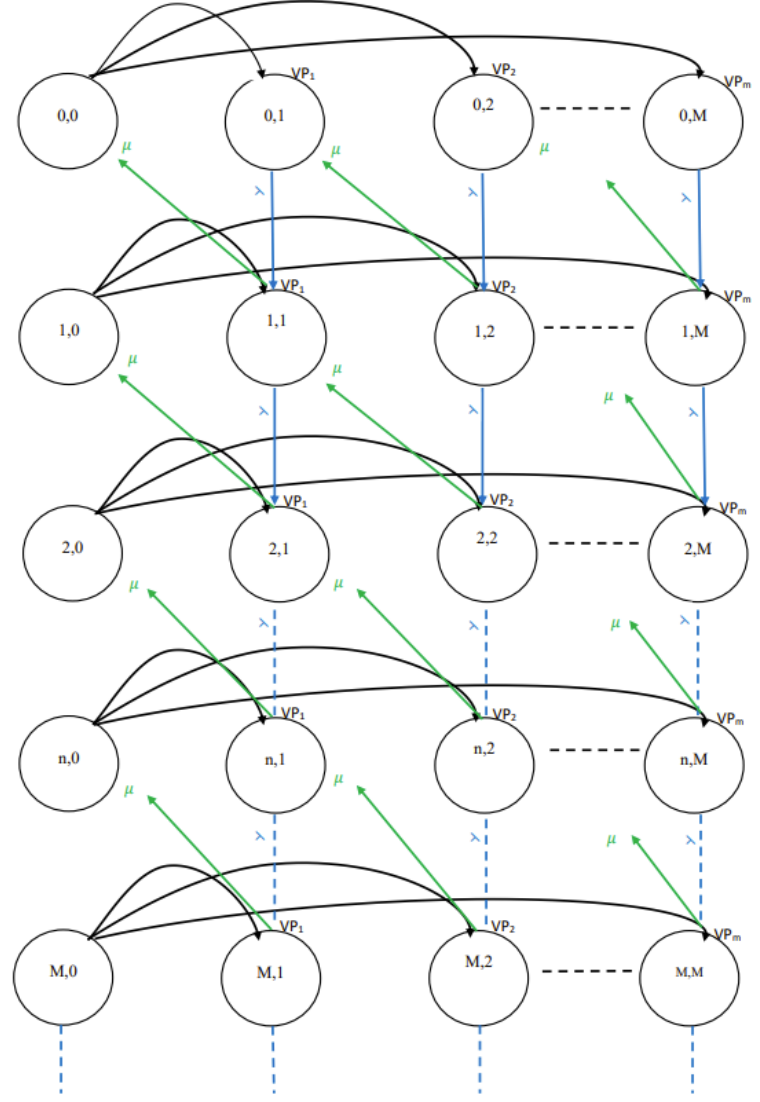
Figure 1. Integrated queuing-inventory model with lost